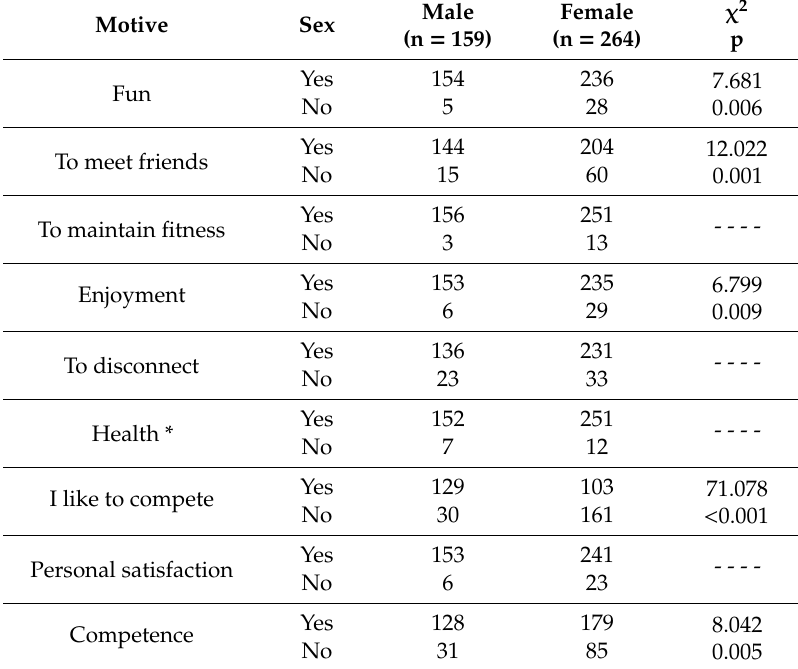
Table 2. Reasons for undertaking physical activity (PA). Variables expressed as absolute frequency (relative frequency). n = 423. Chi-square in function of gender.